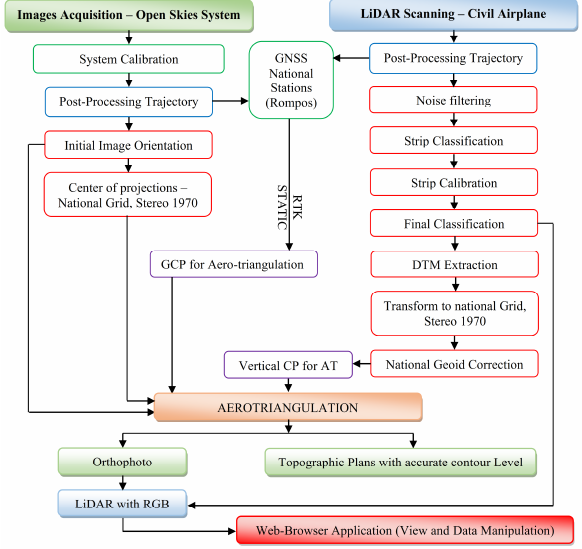
Figure 5 . Schematic workflow of using the Open Skies images combined with LiDAR data in civil applications The highway begins from Târgu Mure ș a nd it ends at Târgu Neam ț , with a length of 214 km. The relief varies from 250 to 1500 meters and it is verry well wooded in the mountain